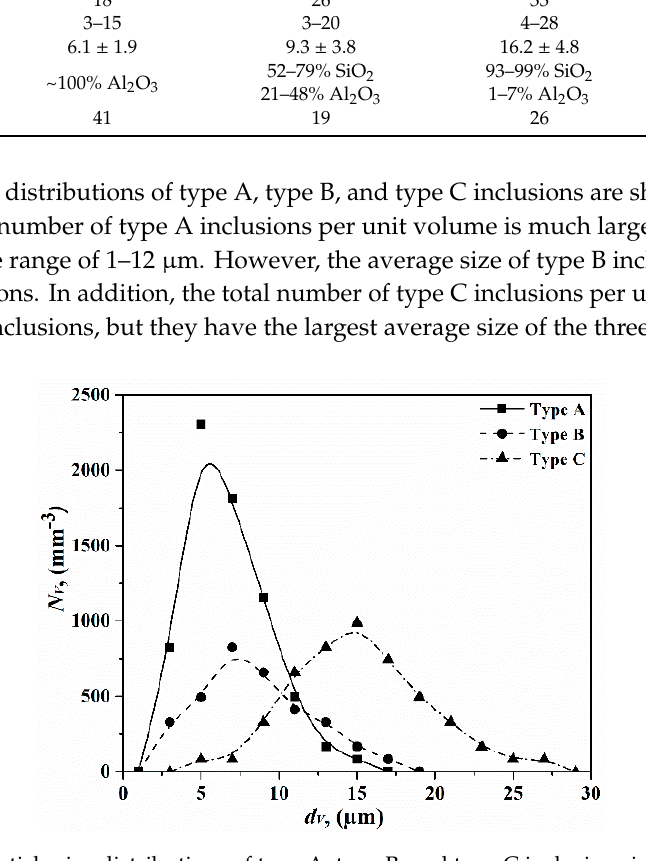
Figure 4. Particle size distributions of type A, type B, and type C inclusions in FeB alloys.